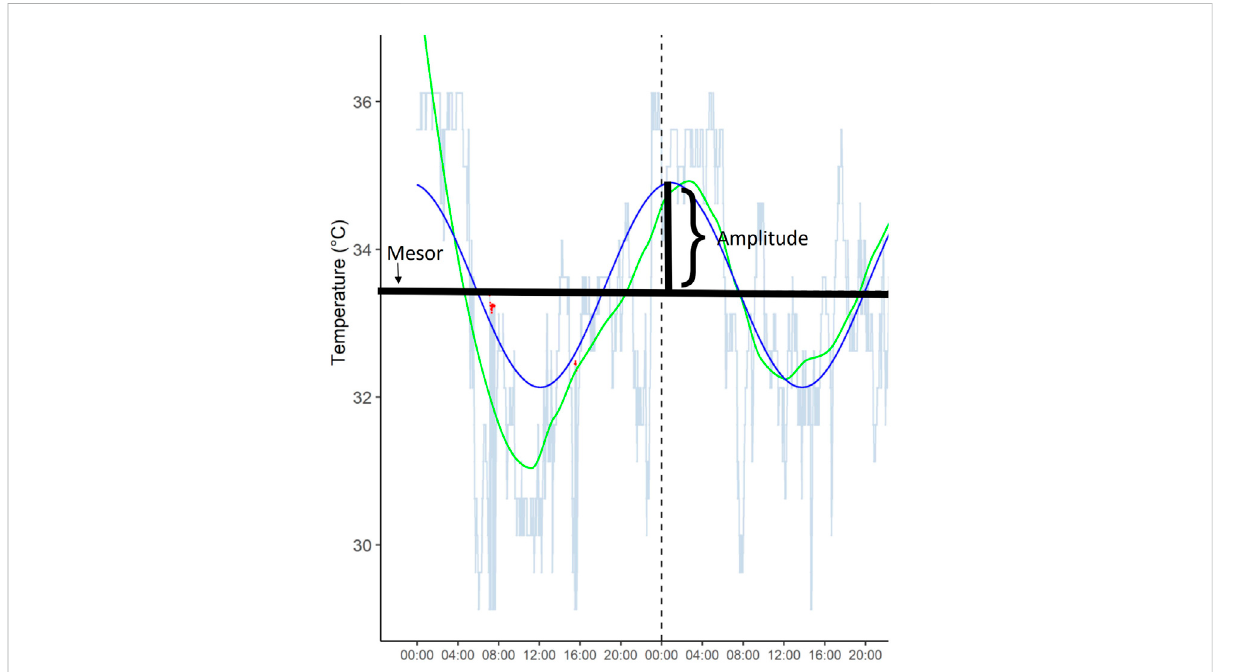
FIGURE 1 A representative example of temperature amplitude and mesor from one participant over 48